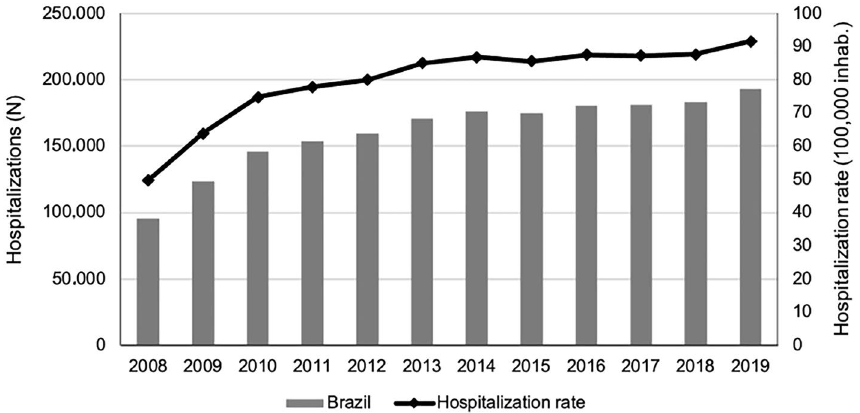
Figure 1. Trend in hospitalizations for land transport accidents (absolute and rate per 100,000 inhabitants) from 2008 to 2019,